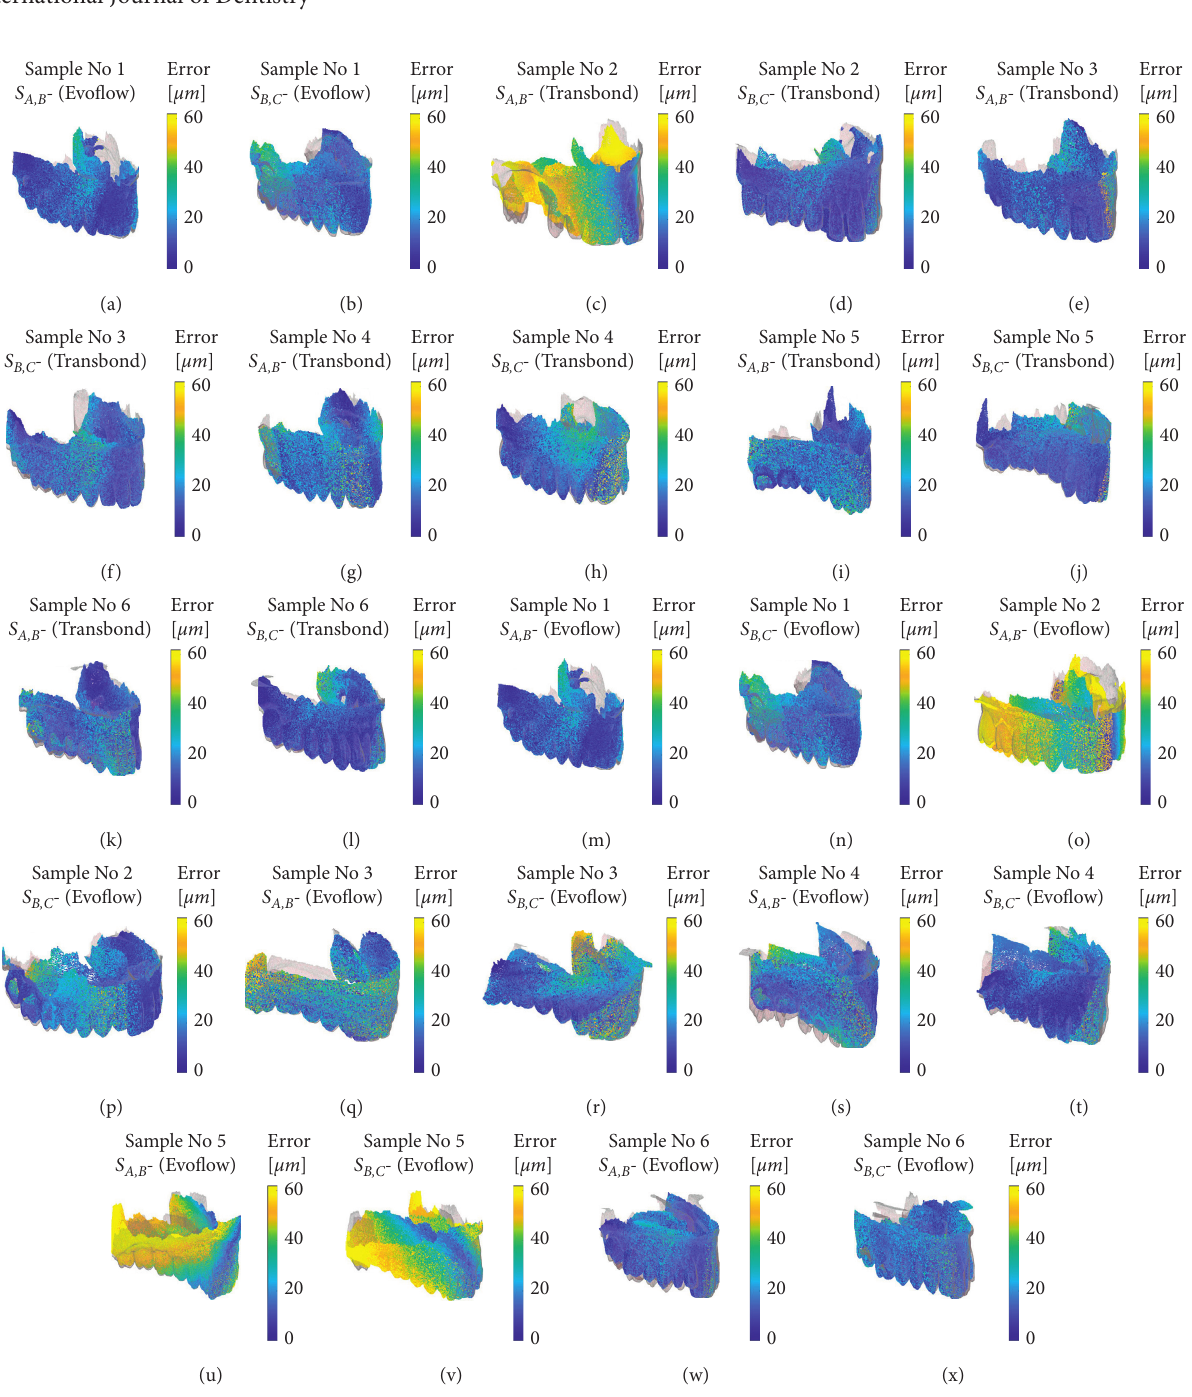
Figure 3: Scatter plot of the relative distance between the A-B and A-C samples in all considered